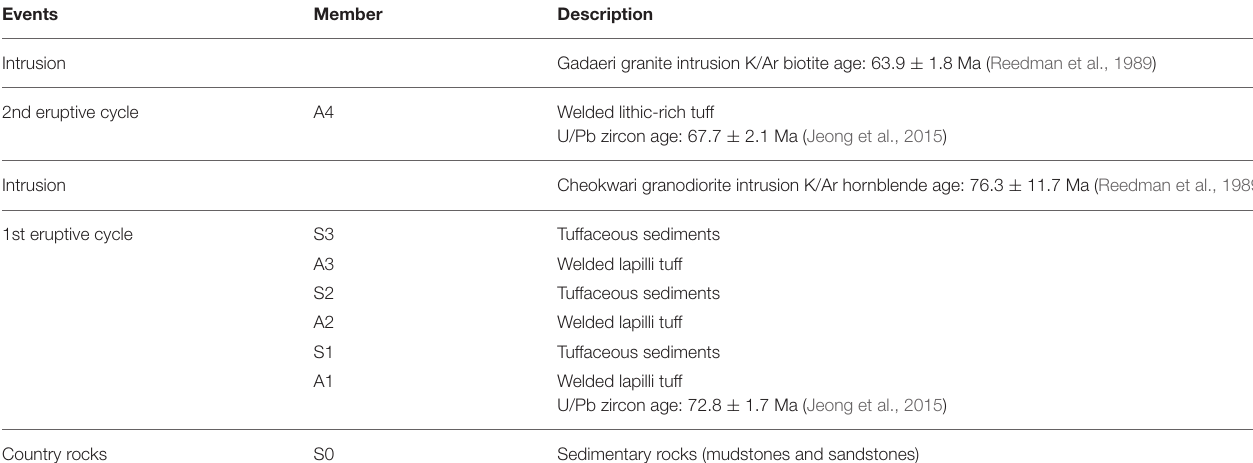
TABLE 1 | Stratigraphy of Chisulryoung Volcanic Formation (CVF).